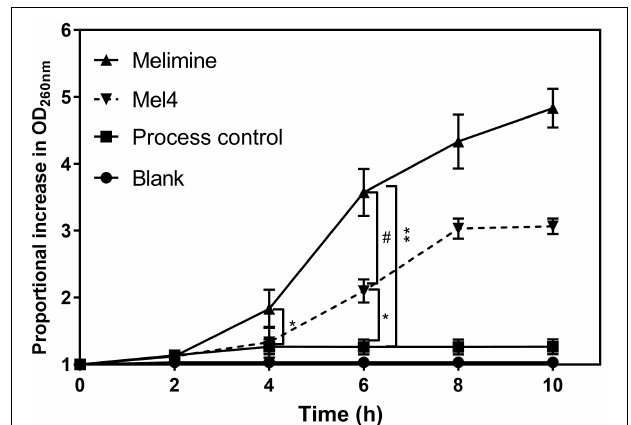
FIGURE 7 | Release of nucleic acid after exposure to bound AMPs. The release of UV absorbing materials (nucleic acids) was determined spectroscopically at 260 nm in the supernatant of bacteria incubated with peptides attached surfaces. Error bars represent means ( ± SD) of three independent repeats in triplicate. * p = 0.005 and ** p < 0.001 compared to process control while # p < 0.001 compared to